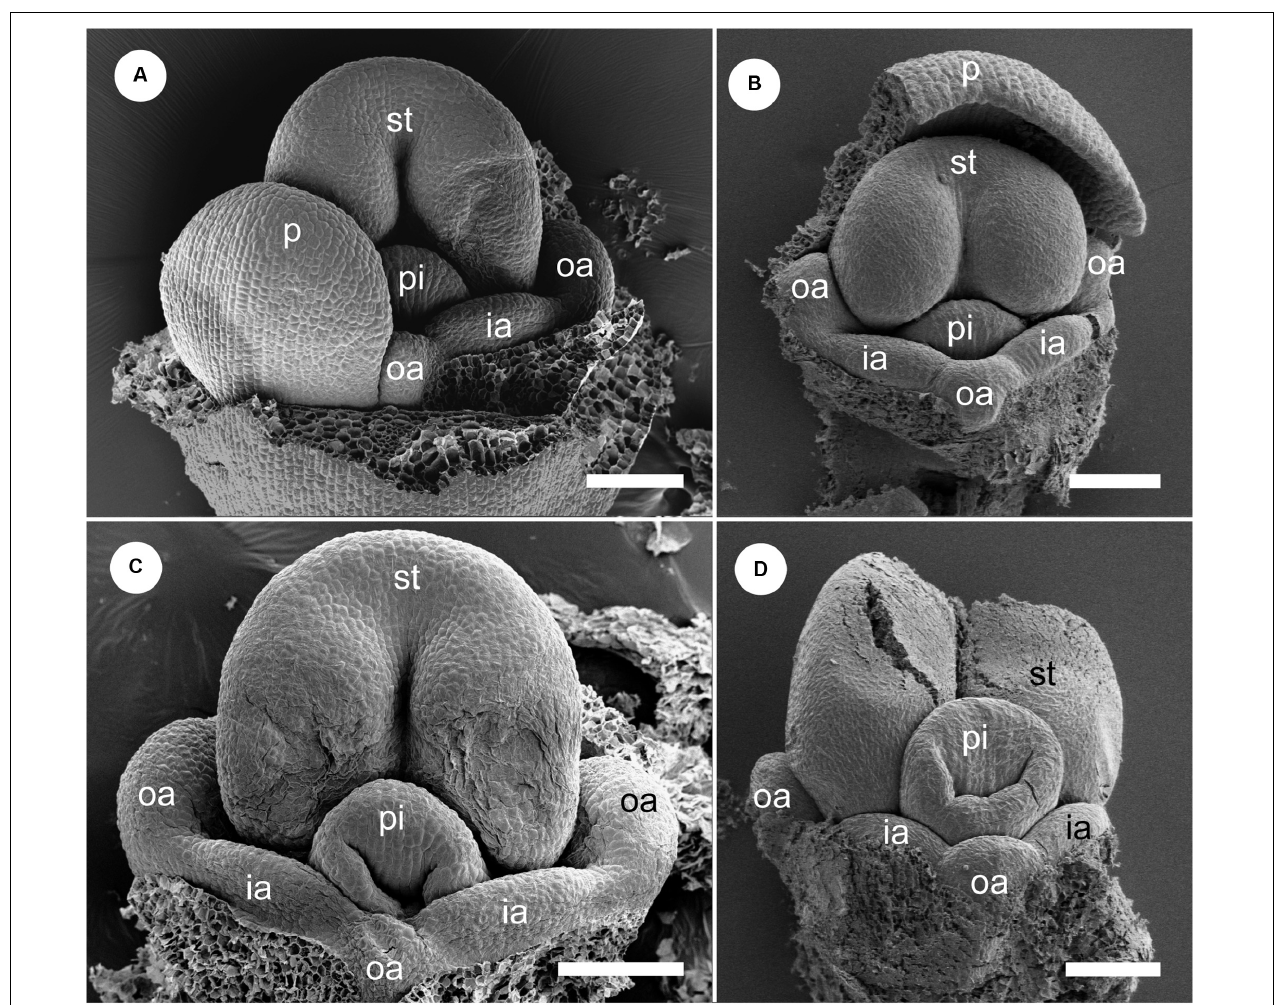
FIGURE 8 | Floral development of Gagnepainia harmandii (continued). Petals and sepals are removed. (A , B) Flowers at almost the same developmental stage as Figure 6F (middle stage). One of the abaxial petal primordia (p) is not removed in (A) . The androecial primordia are still small, but the boundaries between the abaxial outer androecial primordia (oa) are clear. (C , D) A slit develop at the top of the style (sty). The androecial primordia develop slightly, and the size of the abaxial outer androecial primordium becomes almost the same as the inner androecial primordia (ia) and outer lateral androecial primordia in (D) . ia, inner androecial primordium; la, labellum; oa, outer androecial primordium; p, petal primordium; st, stamen primordium; sty, style. Scale bars = 100 µ